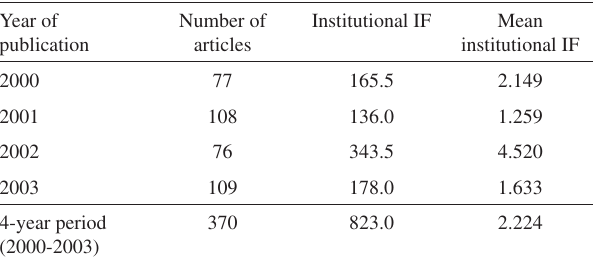
Table 3 - Number of articles published in journals indexed by the Web of Science, Institutional Impact Factors and means for the years 2000 to